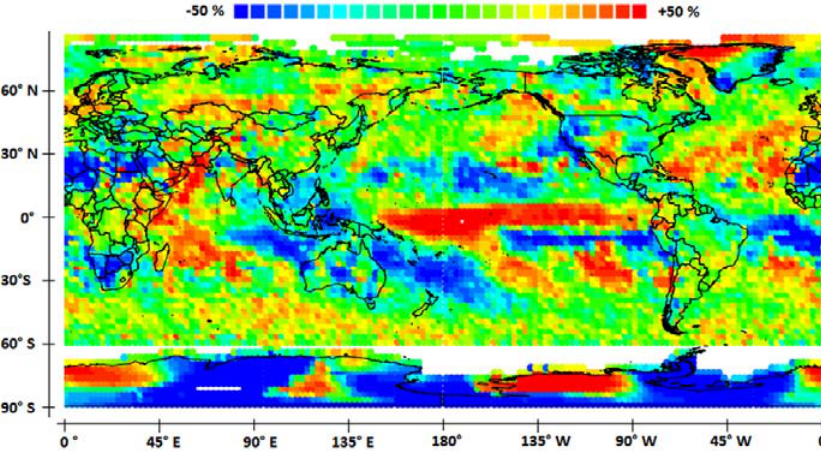
Figure 7. Impact of the ENSO from the variability of precipitation height (the deviation is expressed in % compared to the average precipitation). To each class corresponds an equivalent area within the band 30° S–30° N (quantiles of the total area). The precipitation scale is roughly linear between the two extreme classes (here, − 50% and 50%). However, the two extreme classes include precipitation heights equal to or higher/lower than what is indicated. ENSO events out of phase with the annual QSW are considered.